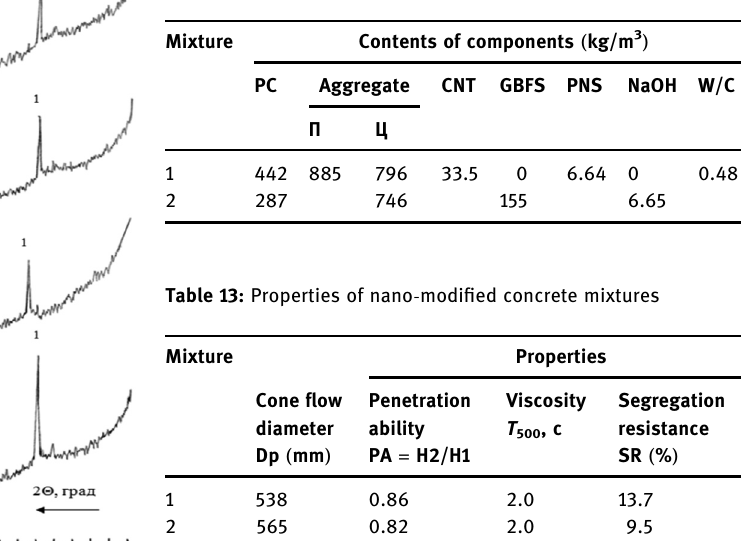
Table 12: Composition of nano - modi fi ed concrete mixtures